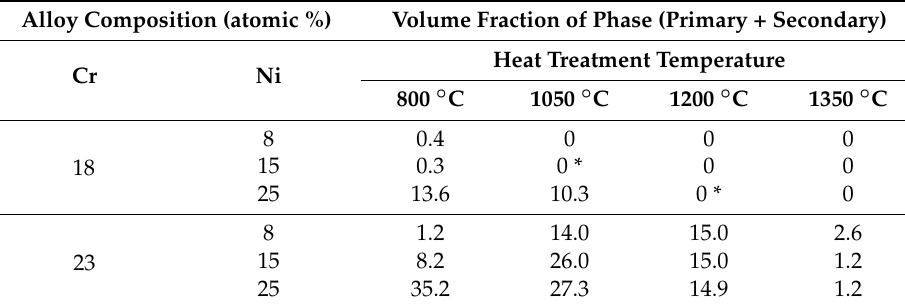
Table 3. Volume fraction of σ phase determined by digital image